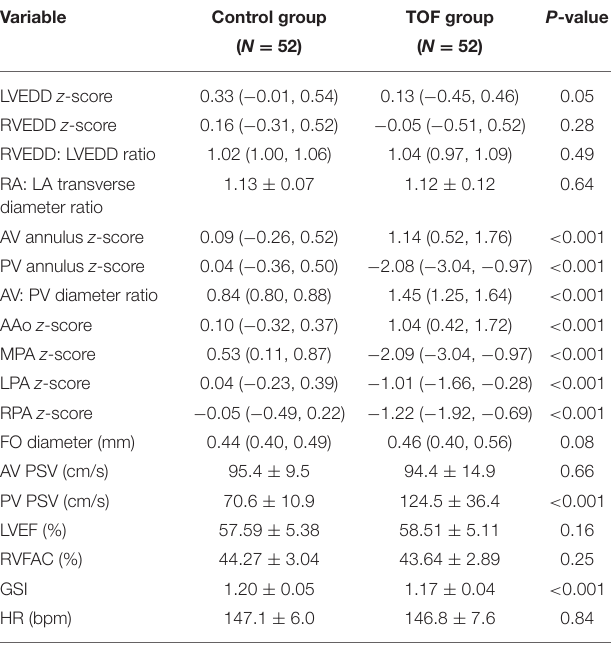
TABLE 3 | Fetal echocardiographic results in fetuses with TOF and controls.